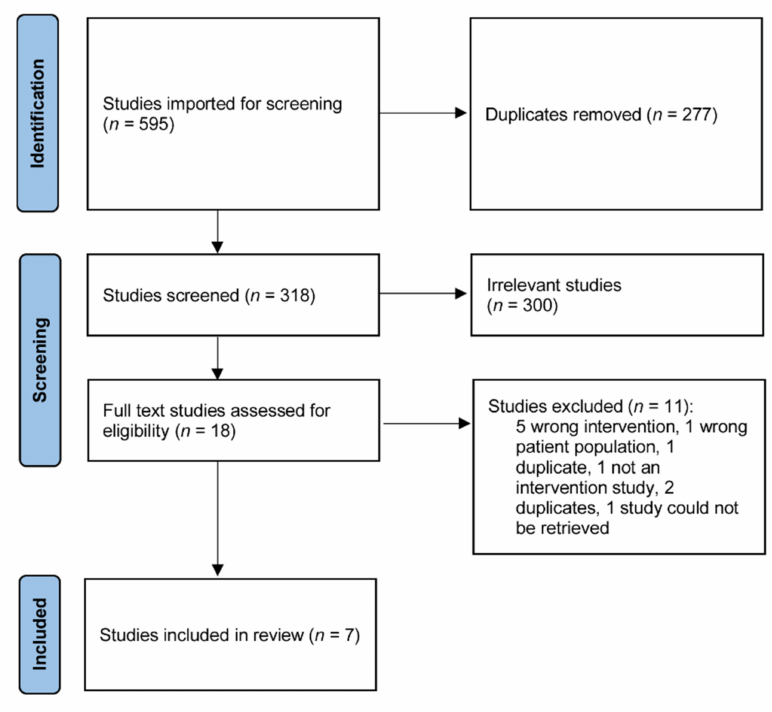
Figure 1. PRISMA flow